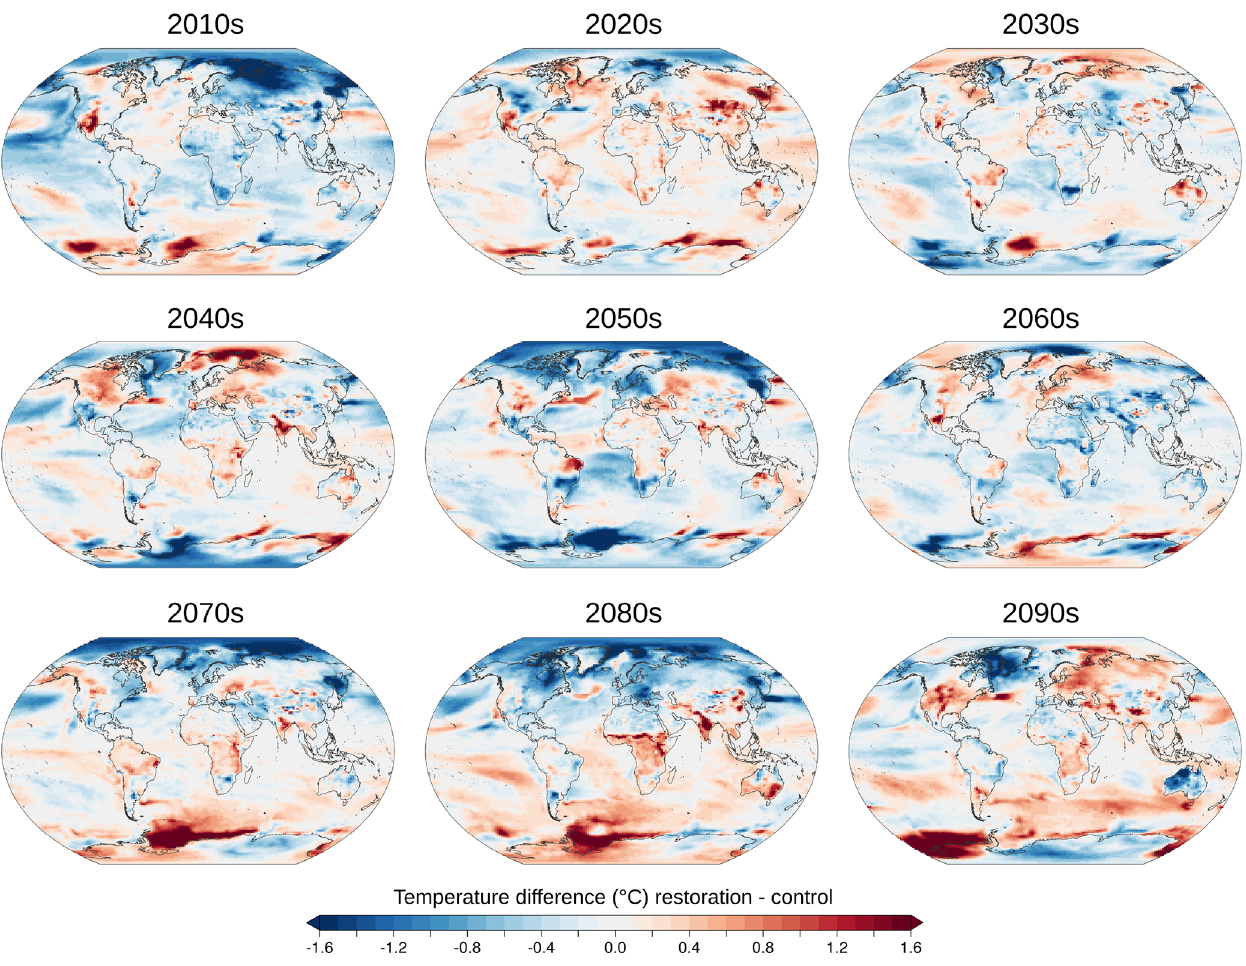
Figure A2. Temperature difference of decadal means between esmrcp26restor and esmrcp26